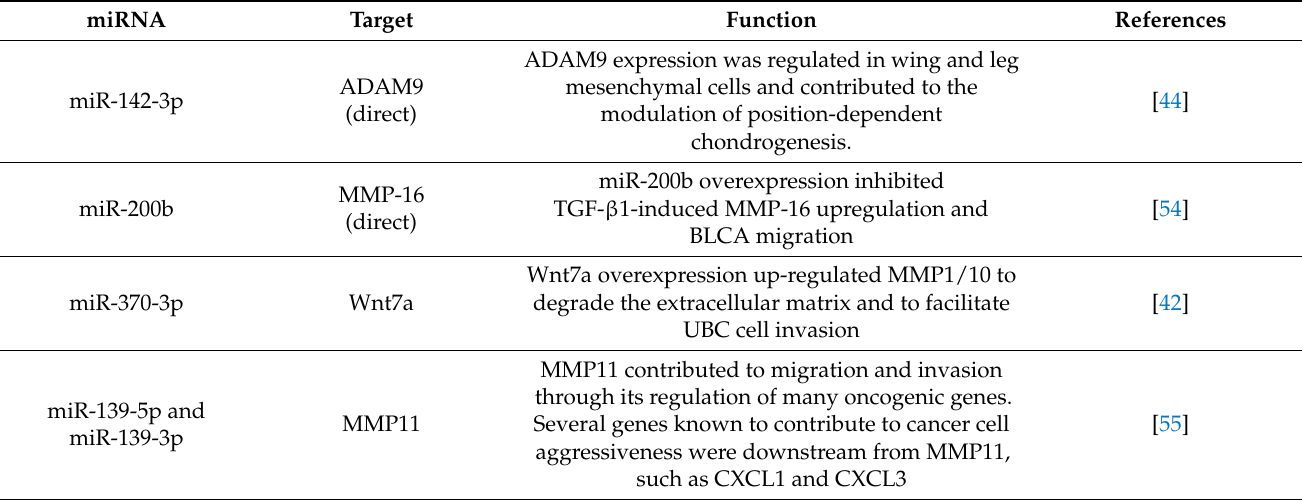
Table 2. Major ECM molecules regulated by miRNAs in BLCA.